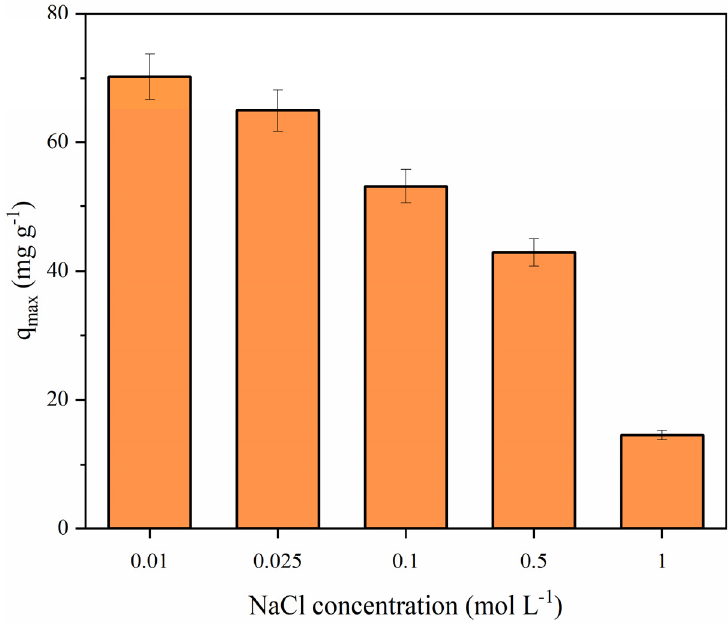
Figure 12. Effect of ionic strength on TC adsorption ( C 0 = 50 mg L − 1 , pH = 7.0, adsorbent dosage = 0.5